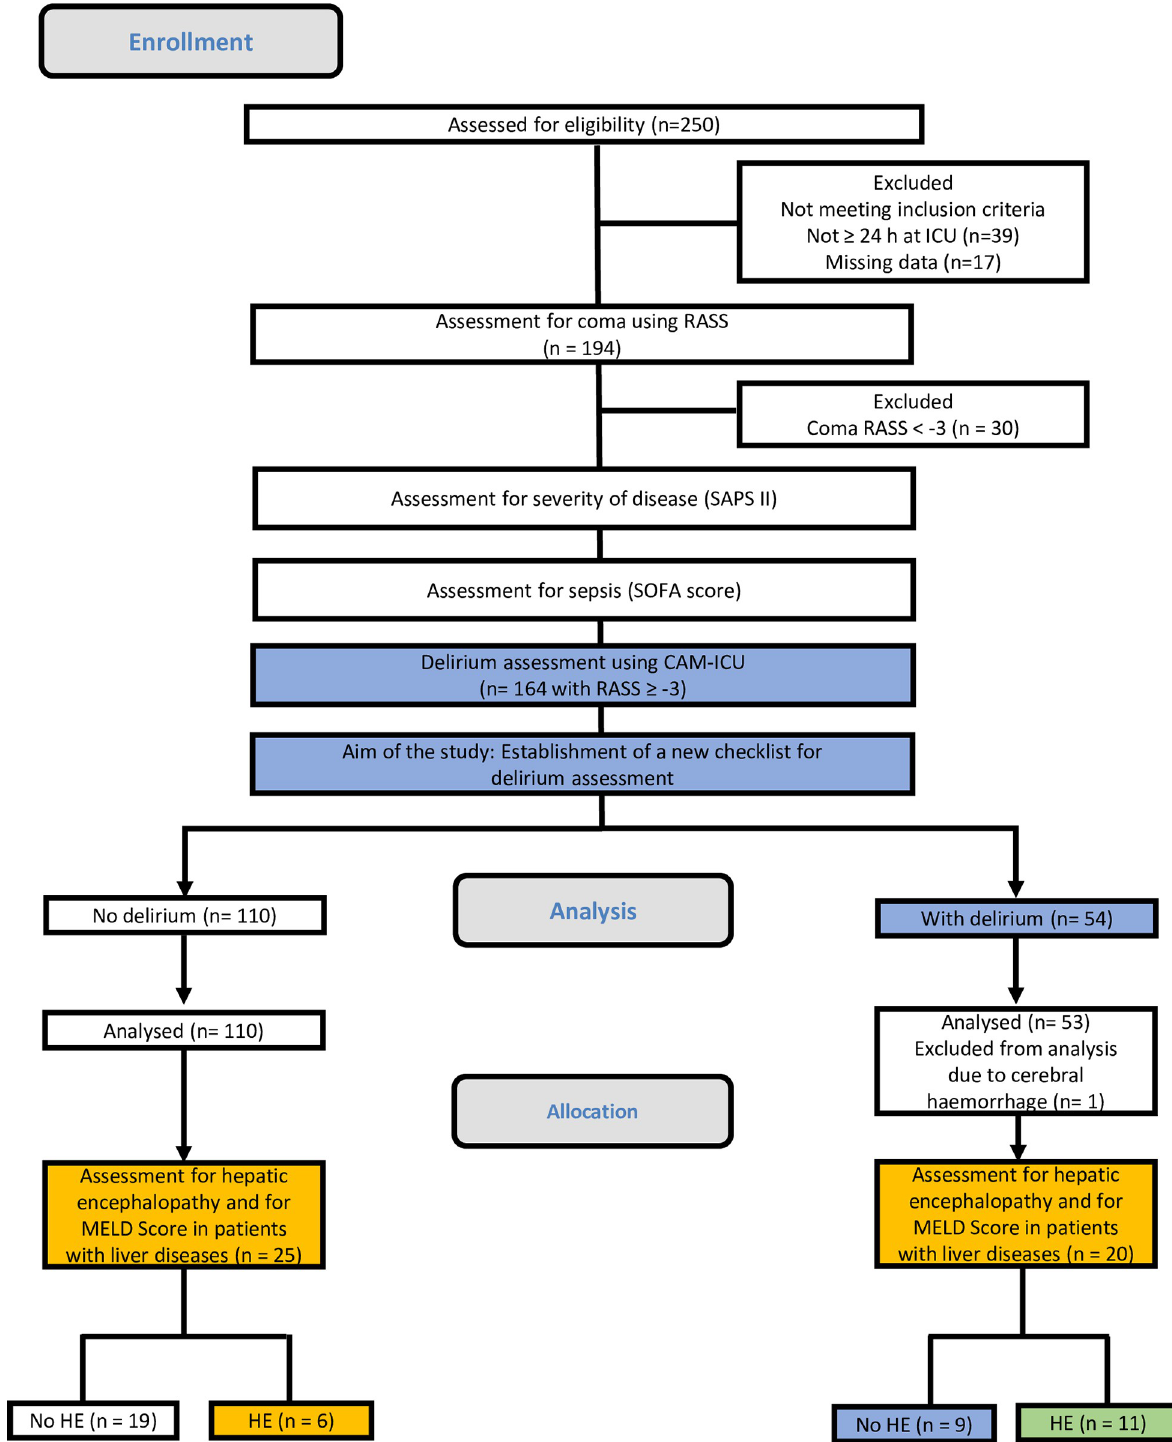
Fig 1. Study design and inclusion of patients. RASS = Richmond Agitation Sedation Scale, SAPS II = Simplified Acute Physiology Score II, SOFA score = Sepsis-related organ failure assessment score, CAM-ICU = Confusion Assessment Method for Intensive Care Unit, HE = Hepatic